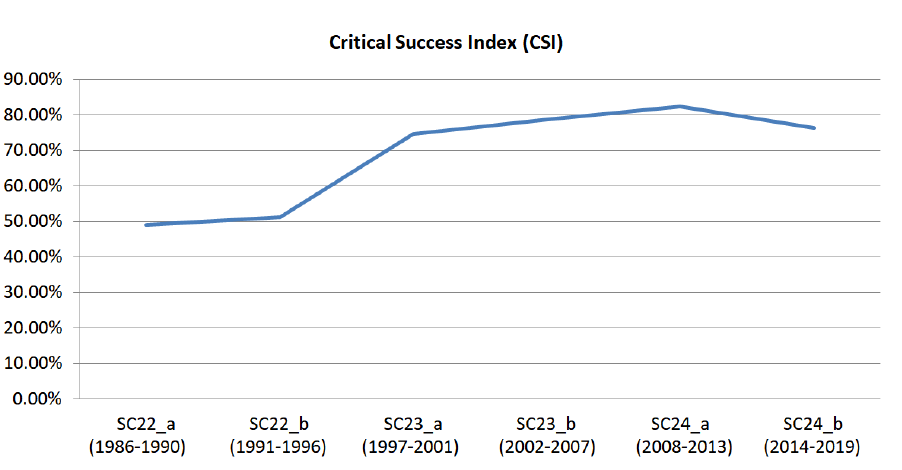
Figure 3. CSI forecasting performance of UMASEP-10 version 2 for each half of the three solar cycles.